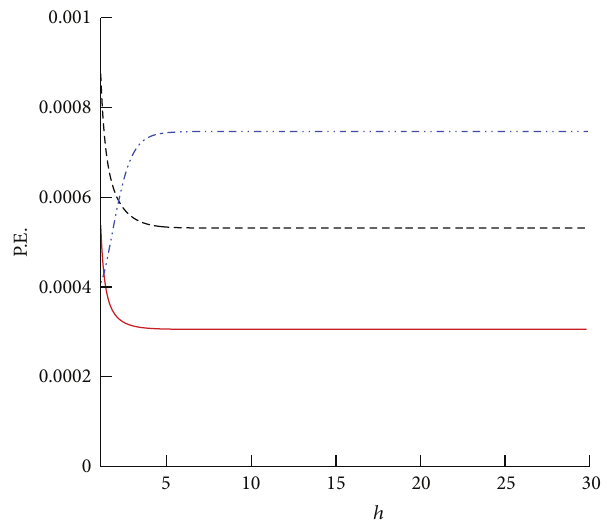
Figure 3: P.E. for (44) versus the water depth ℎ for different plate thicknesses 𝑑 . Solid line: 𝑑 = 0.001 ; dashed line: 𝑑 = 0.005 ; dash- dot-dotted line: 𝑑 = 0.01 .